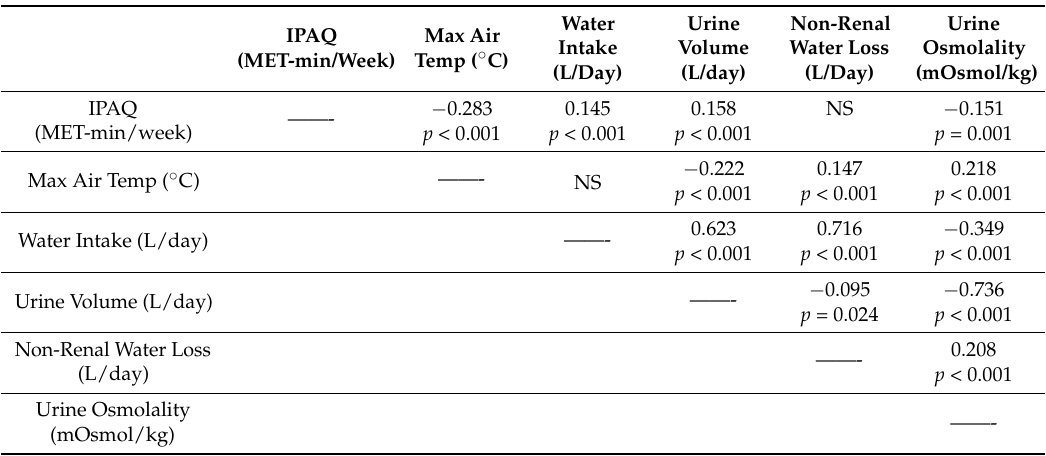
Table 3. Correlation ( r Pearson) among physical activity, maximal air temperature, 24-h water intake/fluid loss and urine osmolality.